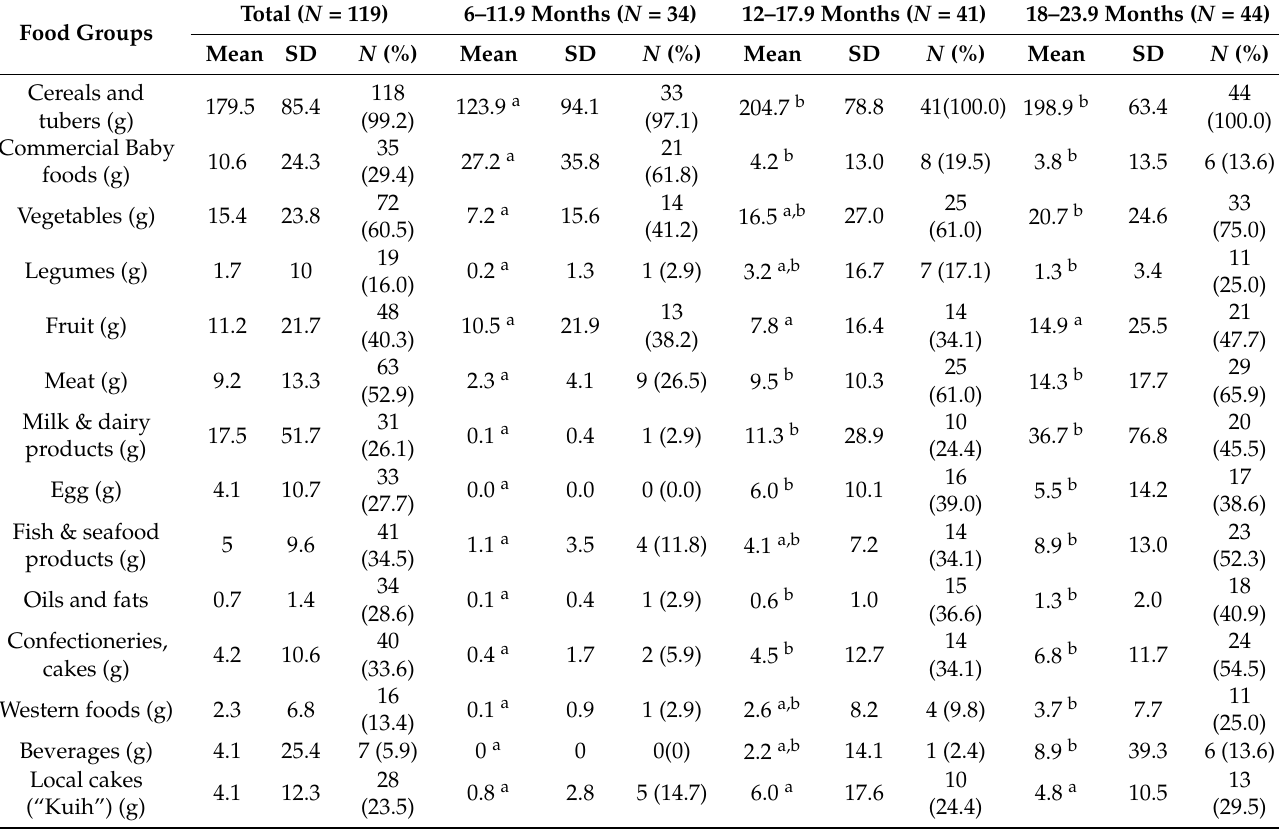
Table 2. Quantities of complementary foods consumed per day (mean ± SD) * according to food category and age group. Food